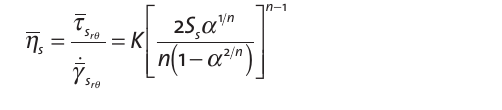
Figure 4 (above): Variation of C(n) with n and a (idealised kneader geometry, b = 2). Figure 5 (below): Relationship between a and n (various A, b =